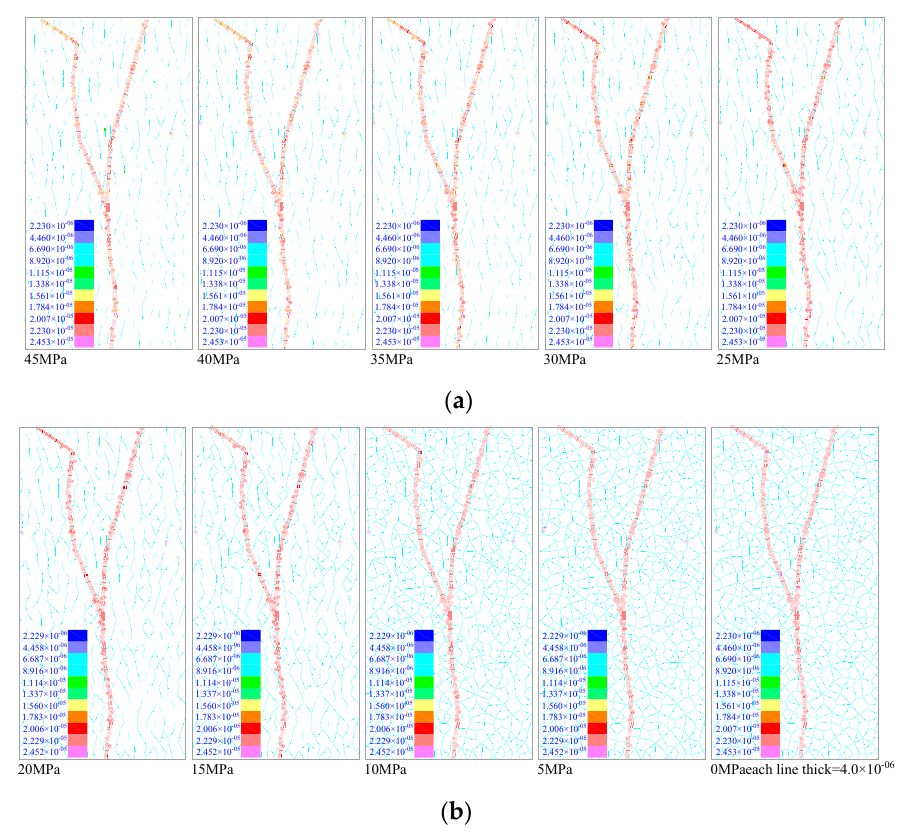
Figure 27. Joint hydraulic aperture. ( a ) 45–25 MPa and ( b ) 20–0 MPa.